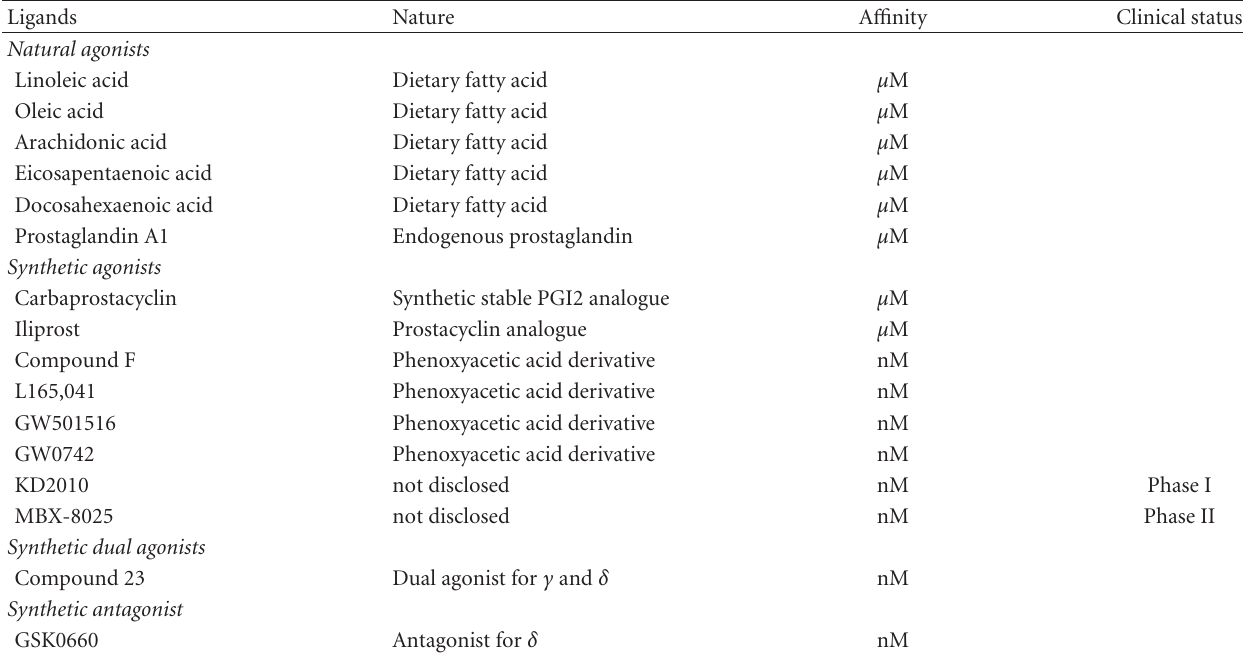
Table 1: Ligands for PPAR- δ